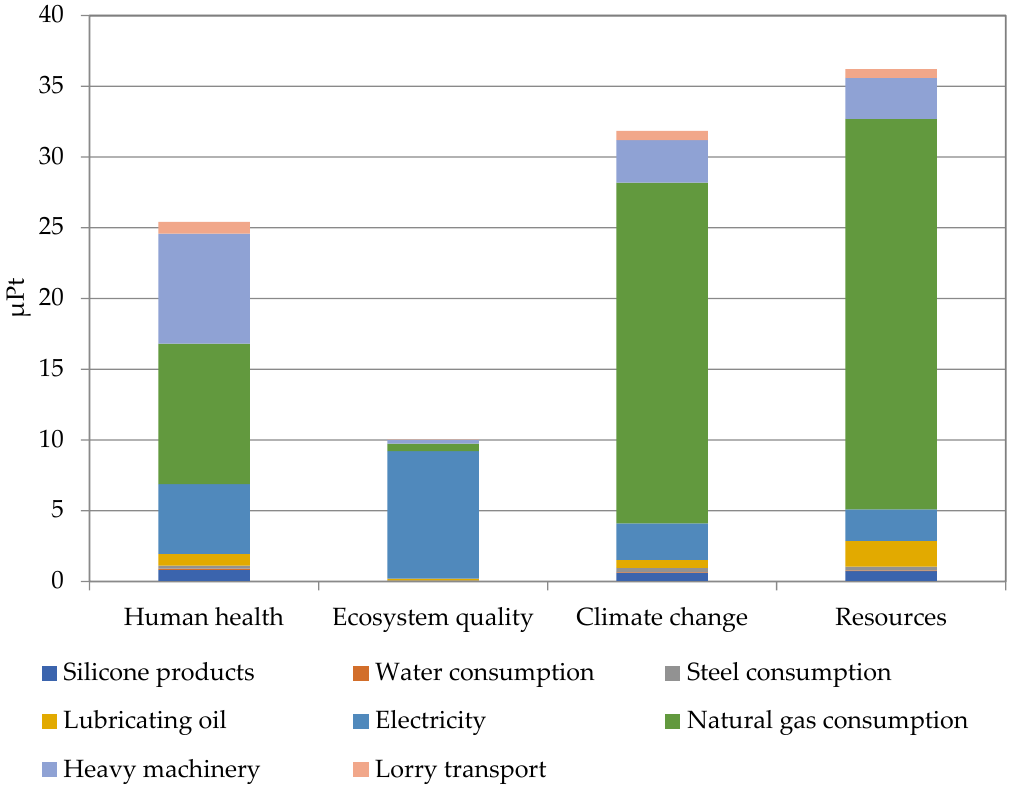
8 of 14 Figure 2. Midpoint impacts of basalt fiber production. The normalized endpoint level impacts represented by human health, ecosystem quality, climate change, and resources are shown in Figure 3. Looking at the results at the endpoint level, the most intense consequences consist of natural gas combustion across all categories except Ecosystem Quality. This endpoint category suffers mostly from electric-